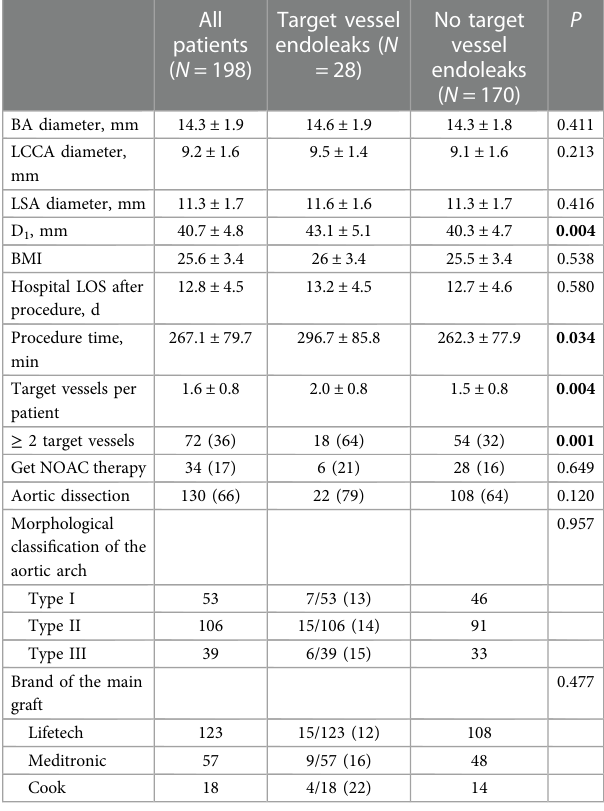
TABLE 1 Factors with the potential to affect TV-related endoleak occurrence after fb-arch repair. All patients